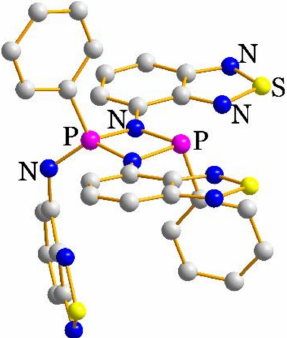
Figure 11. Molecular structure of 4 . Hydrogen atoms are not shown.